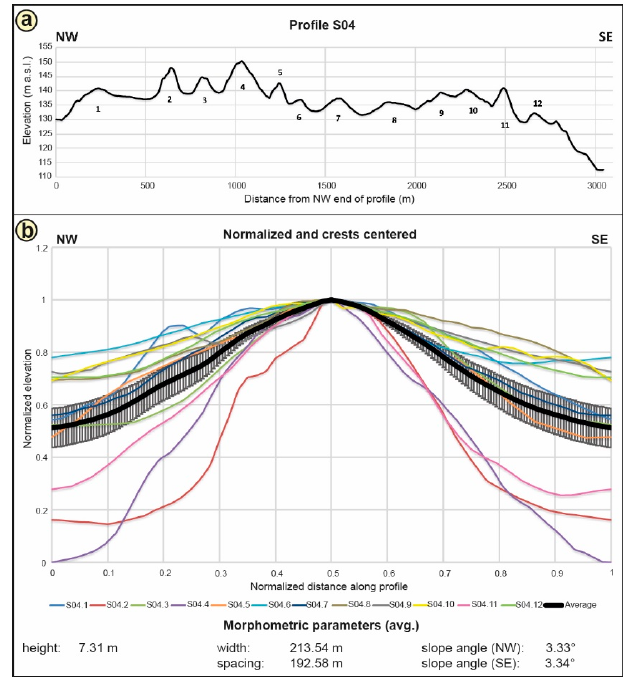
Figure 8. Profile S04 is shown as elevation profile from its distal (NW) to proximal (SE) end with the numbered ridge crests ( a ); The stacked profiles of the elevation profile include the average graph (thick black graph) and error bars (±1 standard deviation) ( b ). The morphometric parameters—mean height, width, spacing, and slope angles—are shown below.